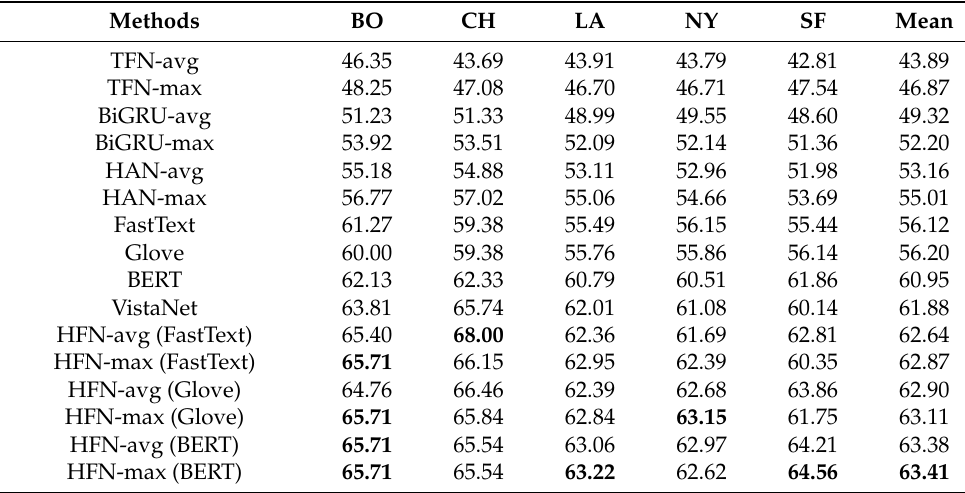
Table 3. Performance comparison to baselines on classification